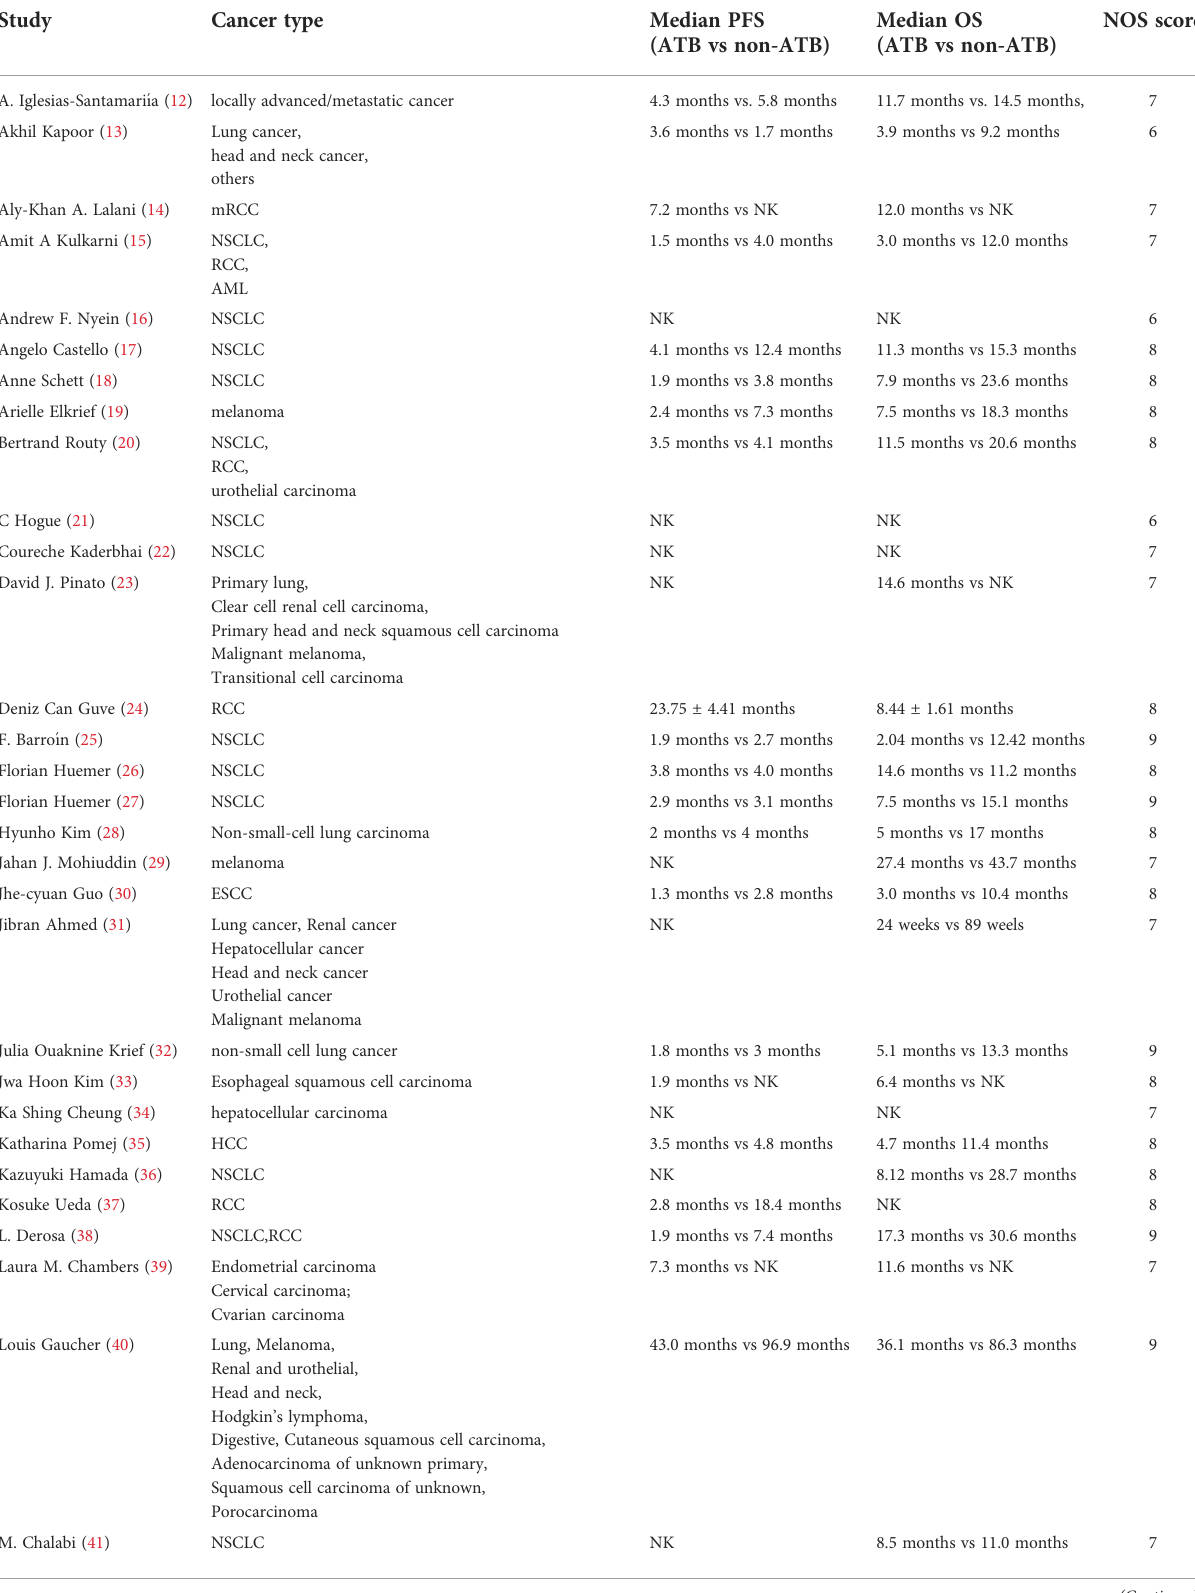
TABLE 2 Basic characteristics of the studies included in the meta-analysis (n =